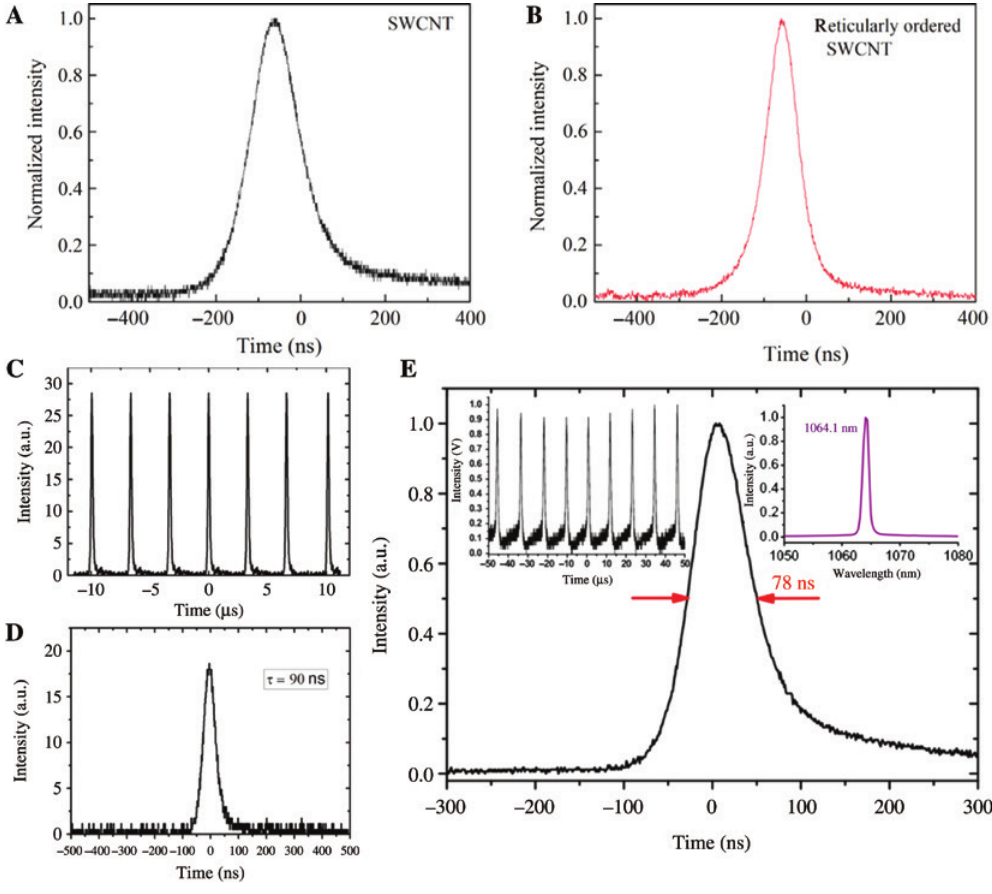
Figure 7: DWCNTs, MWCNTs, the rectangular SWCNTs, and s-SWCNT–based SAs were found that they can be used in the sub–100-ns pulse